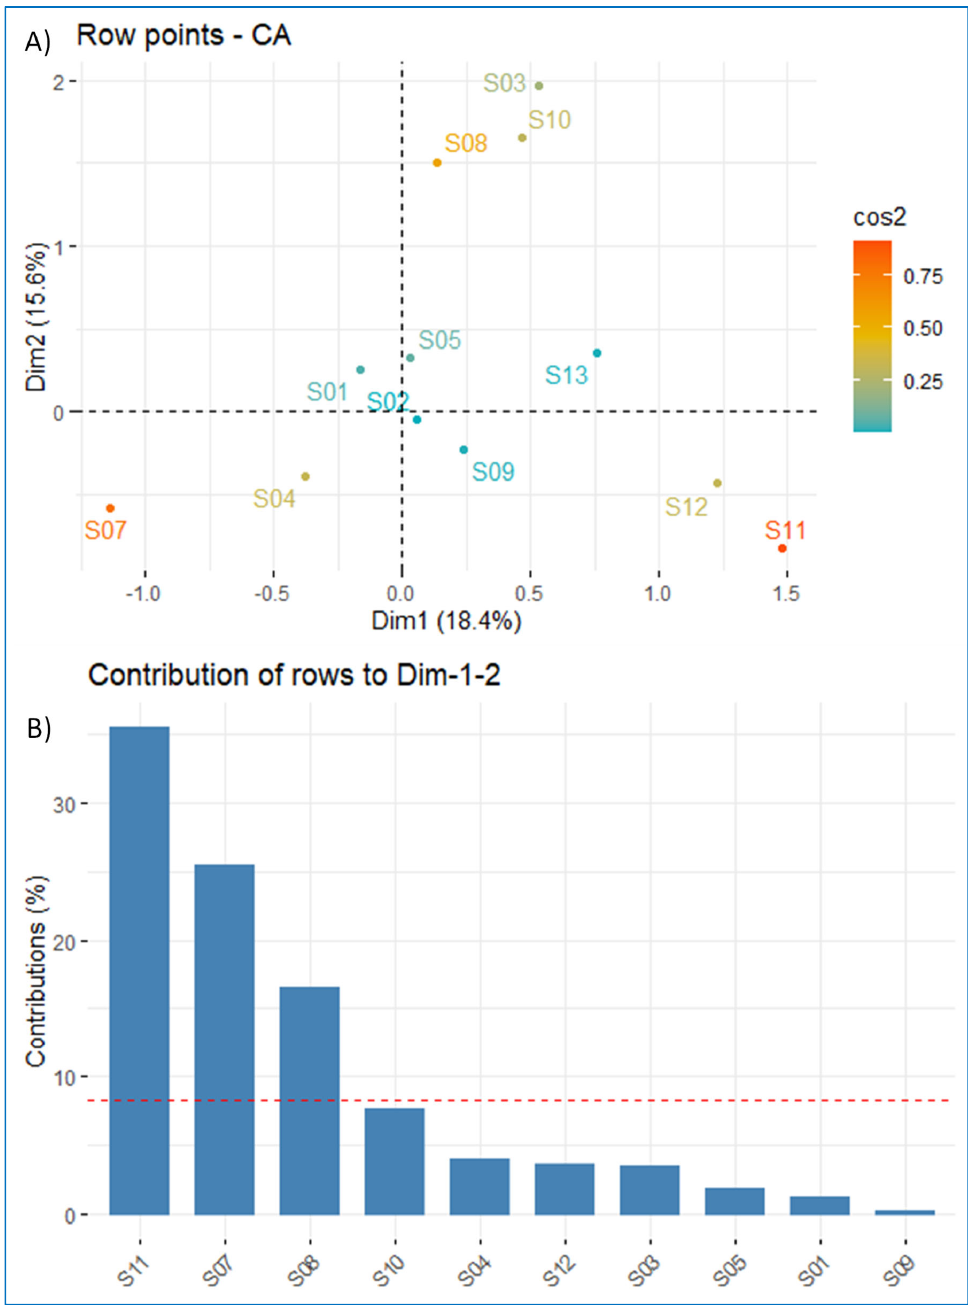
Figure 5. Correspondence factorial analysis (CFA) results of the benthic fauna collected in the thirteen sampling stations of the Casamance estuary: ( A ) represents the plot of sampling stations on the CFA plan and ( B ) represents the contribution of different stations.